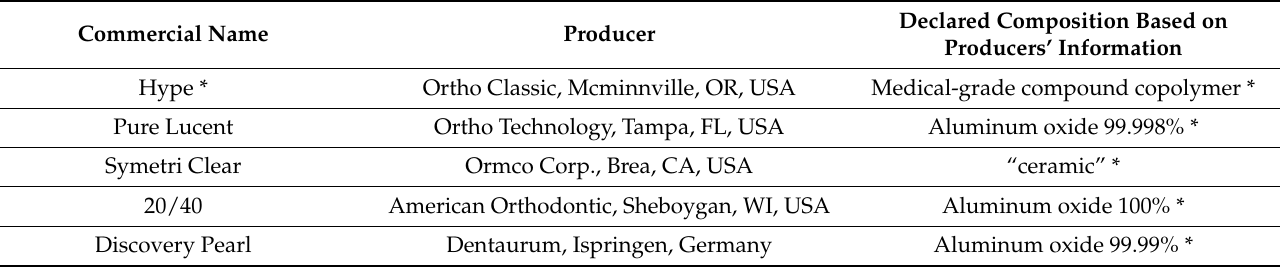
Table 1. Materials assessed in the